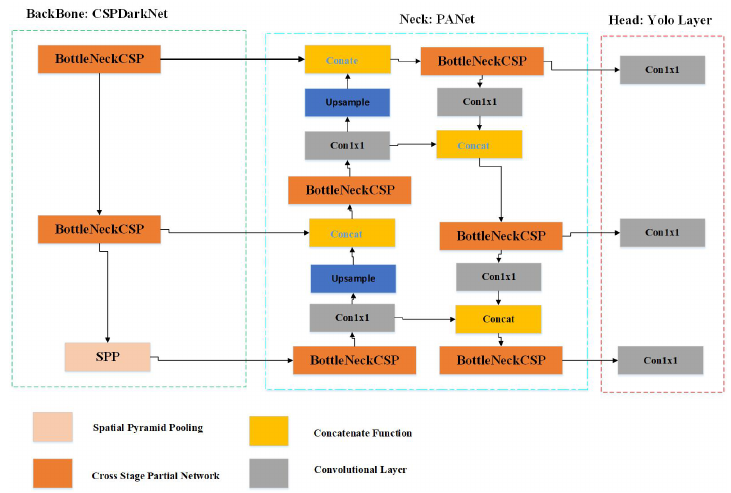
Figure 6. Framework of the YOLOv5s